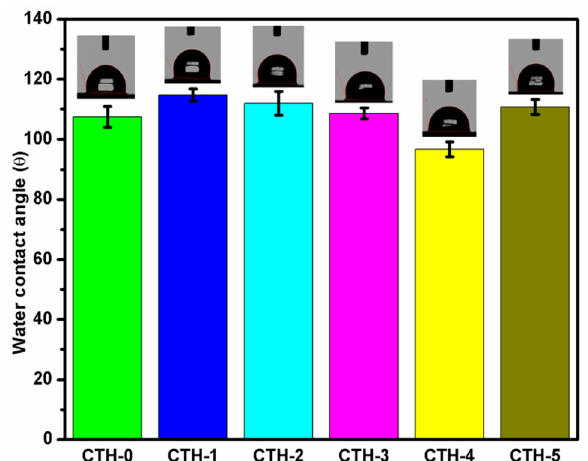
Figure 4. Water contact angles of films with chitosan / PAH ratios of 100 / 0 (CTH-0), 90 / 10 (CTH-1), 80 / 10